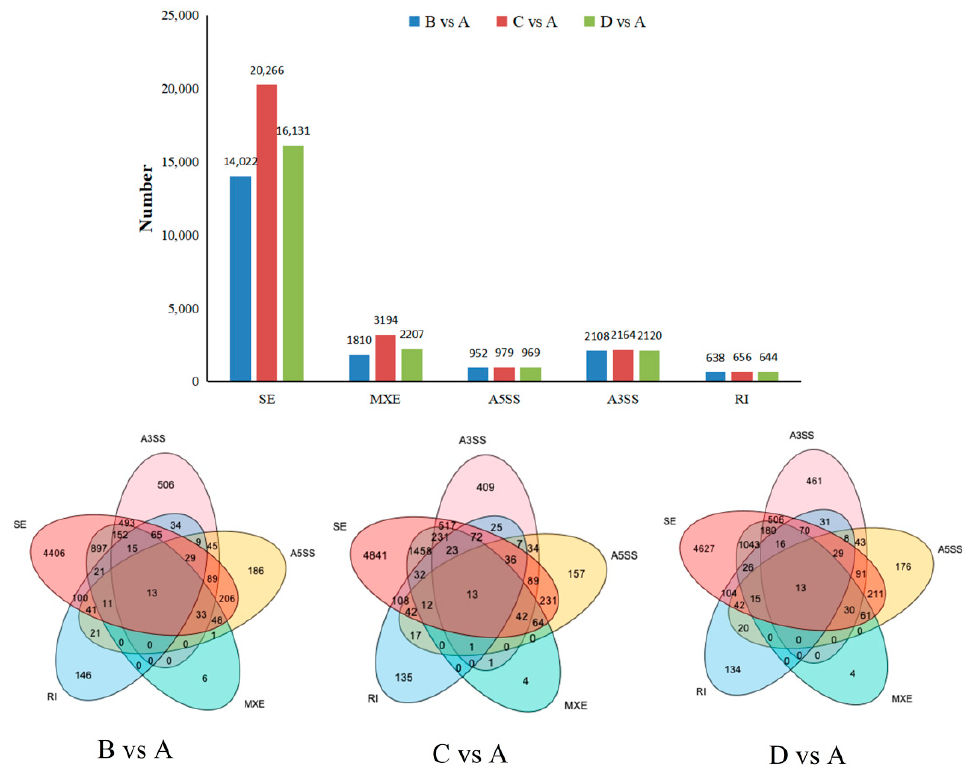
Figure 2. Alternative splicing events identified in the comparison group of wild jujube CK and each treatment. each